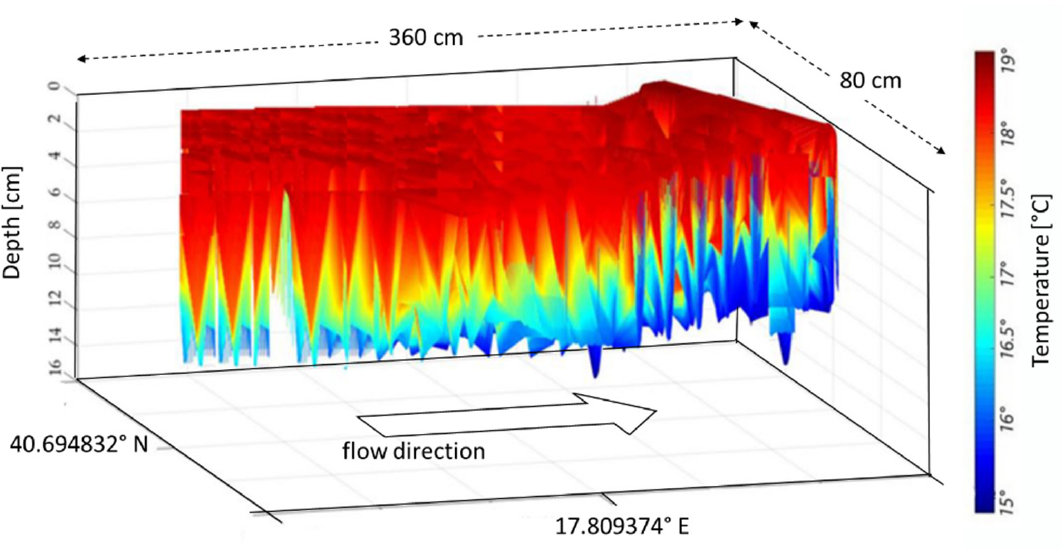
Figure 11. Temperature values retrieved by means of beamforming-based technique vs. depth and GPS references for cross-section B2.